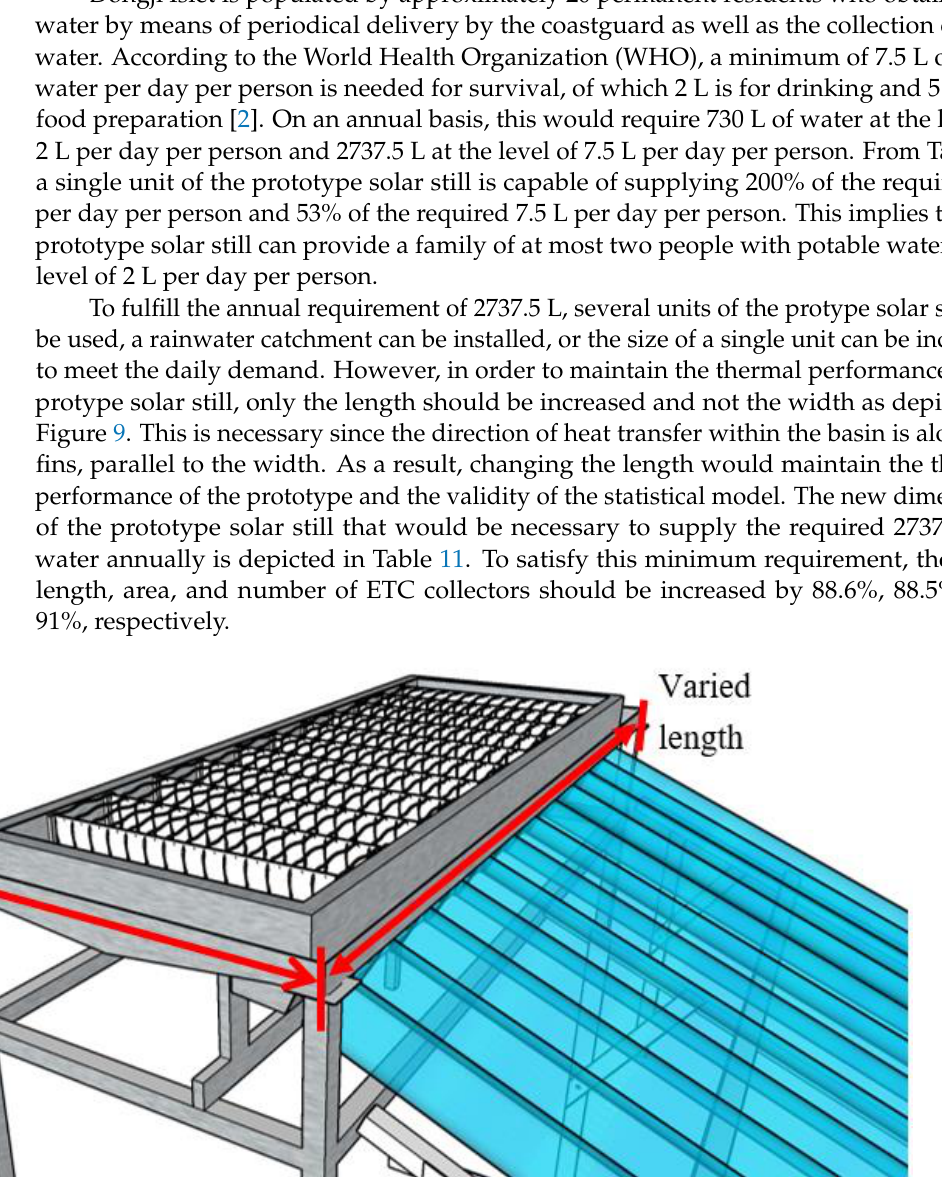
Avg. Batches Batch